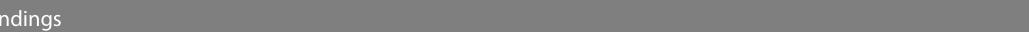
TABLE 1 PSMA imaging interval and follow-up